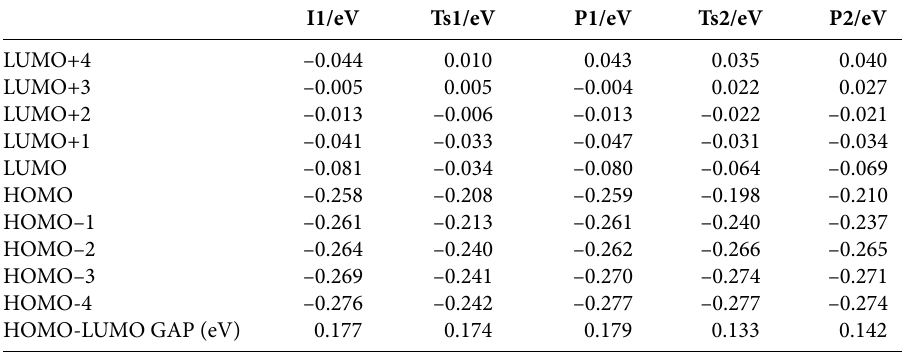
Table 3. Frontier orbitals of reacting species, transition states, intermediates and product computed using B3LYP/6–3